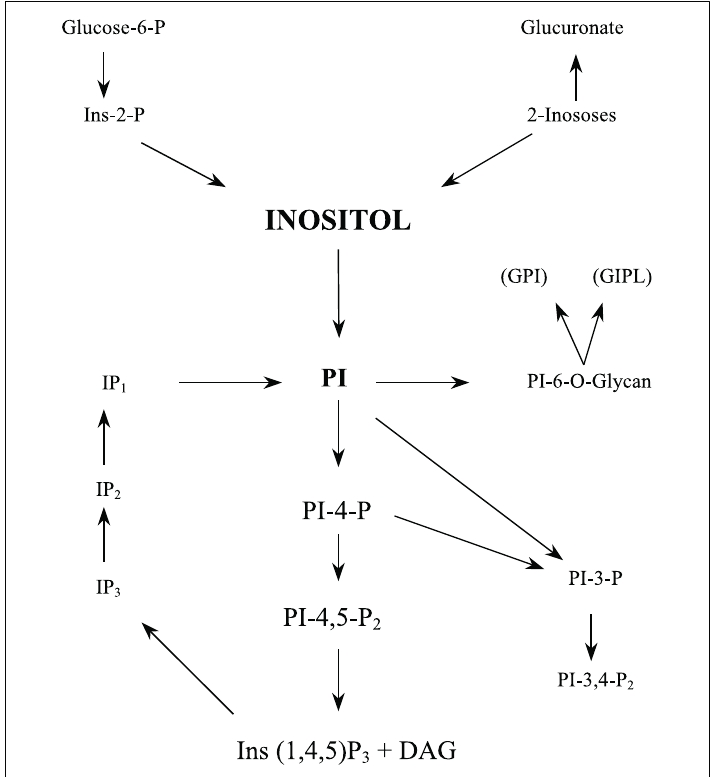
Fig. 1 – myo -inositol metabolic pathways. Symbols: PI - phosphatidylinosi- tol; PI-4-P - phosphatidylinositol-4-phosphate; PI-4,5-P 2 - phosphatidylinositol- 4,5-bisphosphate; Ins(1,4,5)P 3 and IP 3 - inositol trisphosphate; IP 2 - inosi- tol bisphosphate; IP 1 - inositol monophosphate; DAG - diacylglycerol; PI- 3-P - phosphatidylinositol-3-phosphate; PI-3,4-P 2 - phosphatidylinositol-3,4- bisphosphate; PI-6-O-Glycan - phosphatidylinositol-6-ortho-glycan; GPI - gli- cosylphosphatidylinositol; GIPL - glicosylphosphatidylinositol lipid; Ins-2-P -